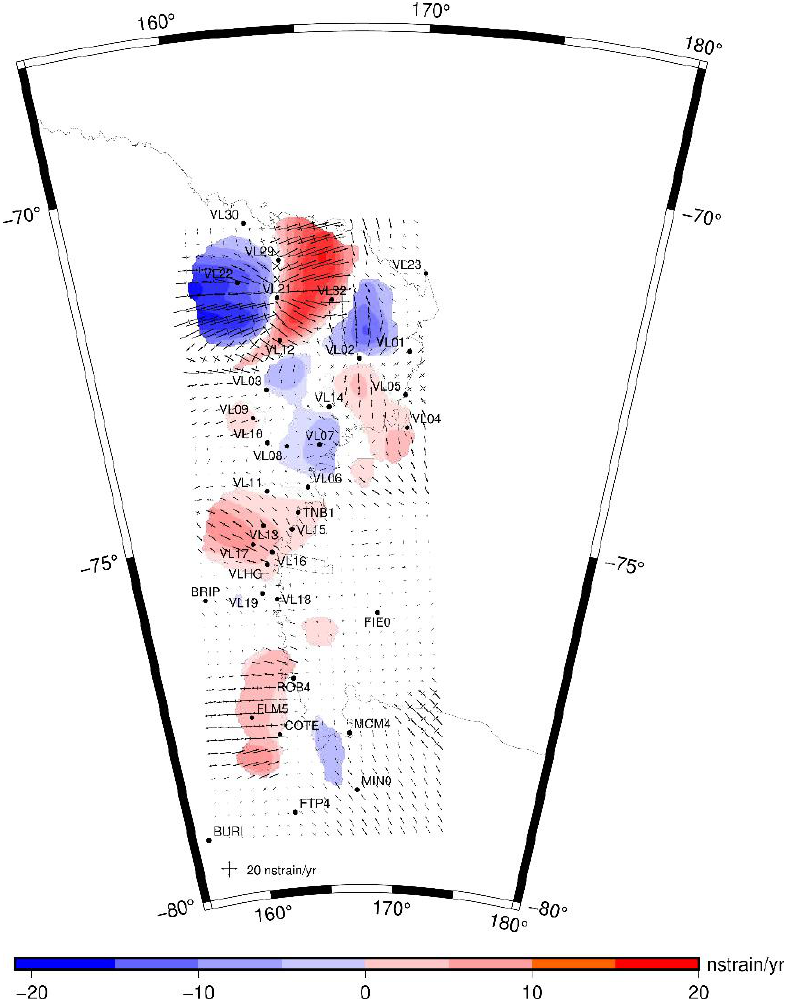
Figure 3. Dilatation rate field computed for Victoria Land. Red and blue colors indicate, respectively, extension or compression statistically significant values at 1σ. Blanked grid cells correspond to area with statistically not significant values.